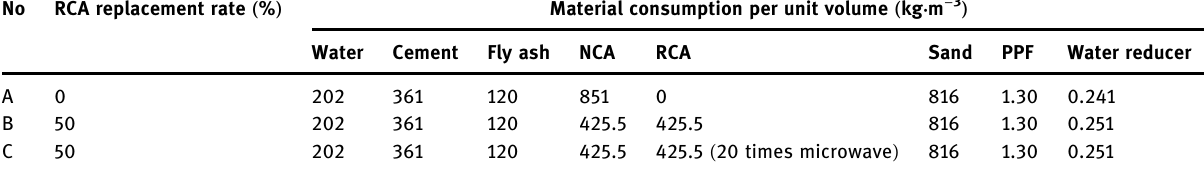
Table 2: Mix ratio design